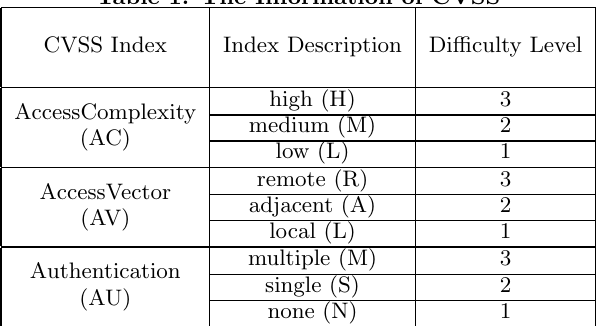
Table 1: The Information of CVSS